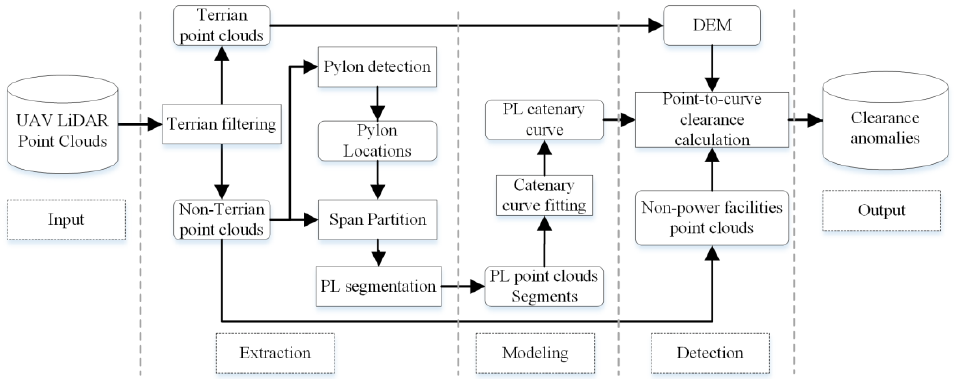
Figure 1. Schematic diagram of the proposed workflow.